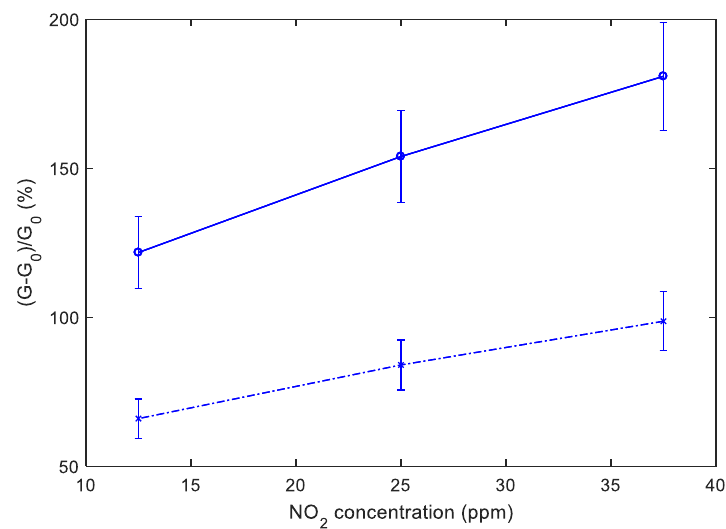
Figure 14. Au-decorated sensor response to NO 2 as a function of the NO 2 concentration using the measurement profile shown in Figure 8. Dashed line: Response sampled at the end of the last T high pulse of each NO 2 injection, solid line: Response sampled at the end of the last T low pulse of each NO 2 injection; the error bars refer to the estimated repeatability (approximately 10% of the response value).